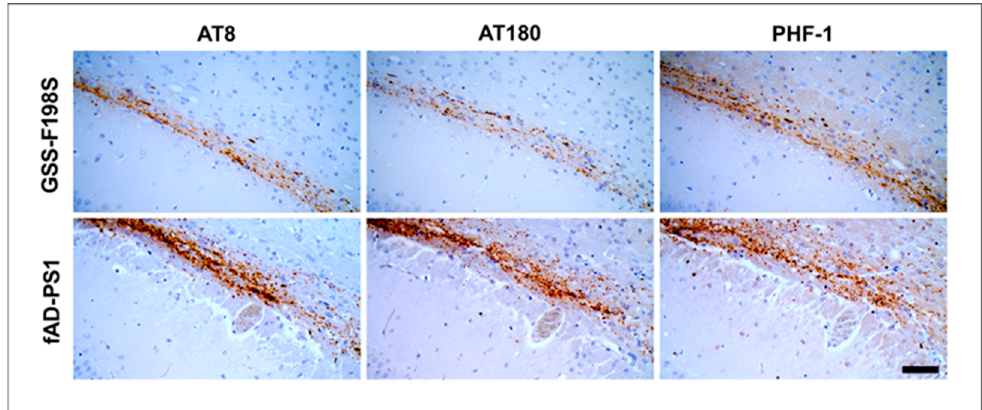
Figure 4. Filamentous Tau pathology in the alveus of BvM inoculated with GSS-F198S and fAD-PS1. Using different anti-Tau antibodies, AT8, AT180, and PHF-1, respectively, against Ser202-Thr205, pT231 and pS396/pS404 epitopes, the same pTau deposition pattern was observed. Scale bar 20 µm.